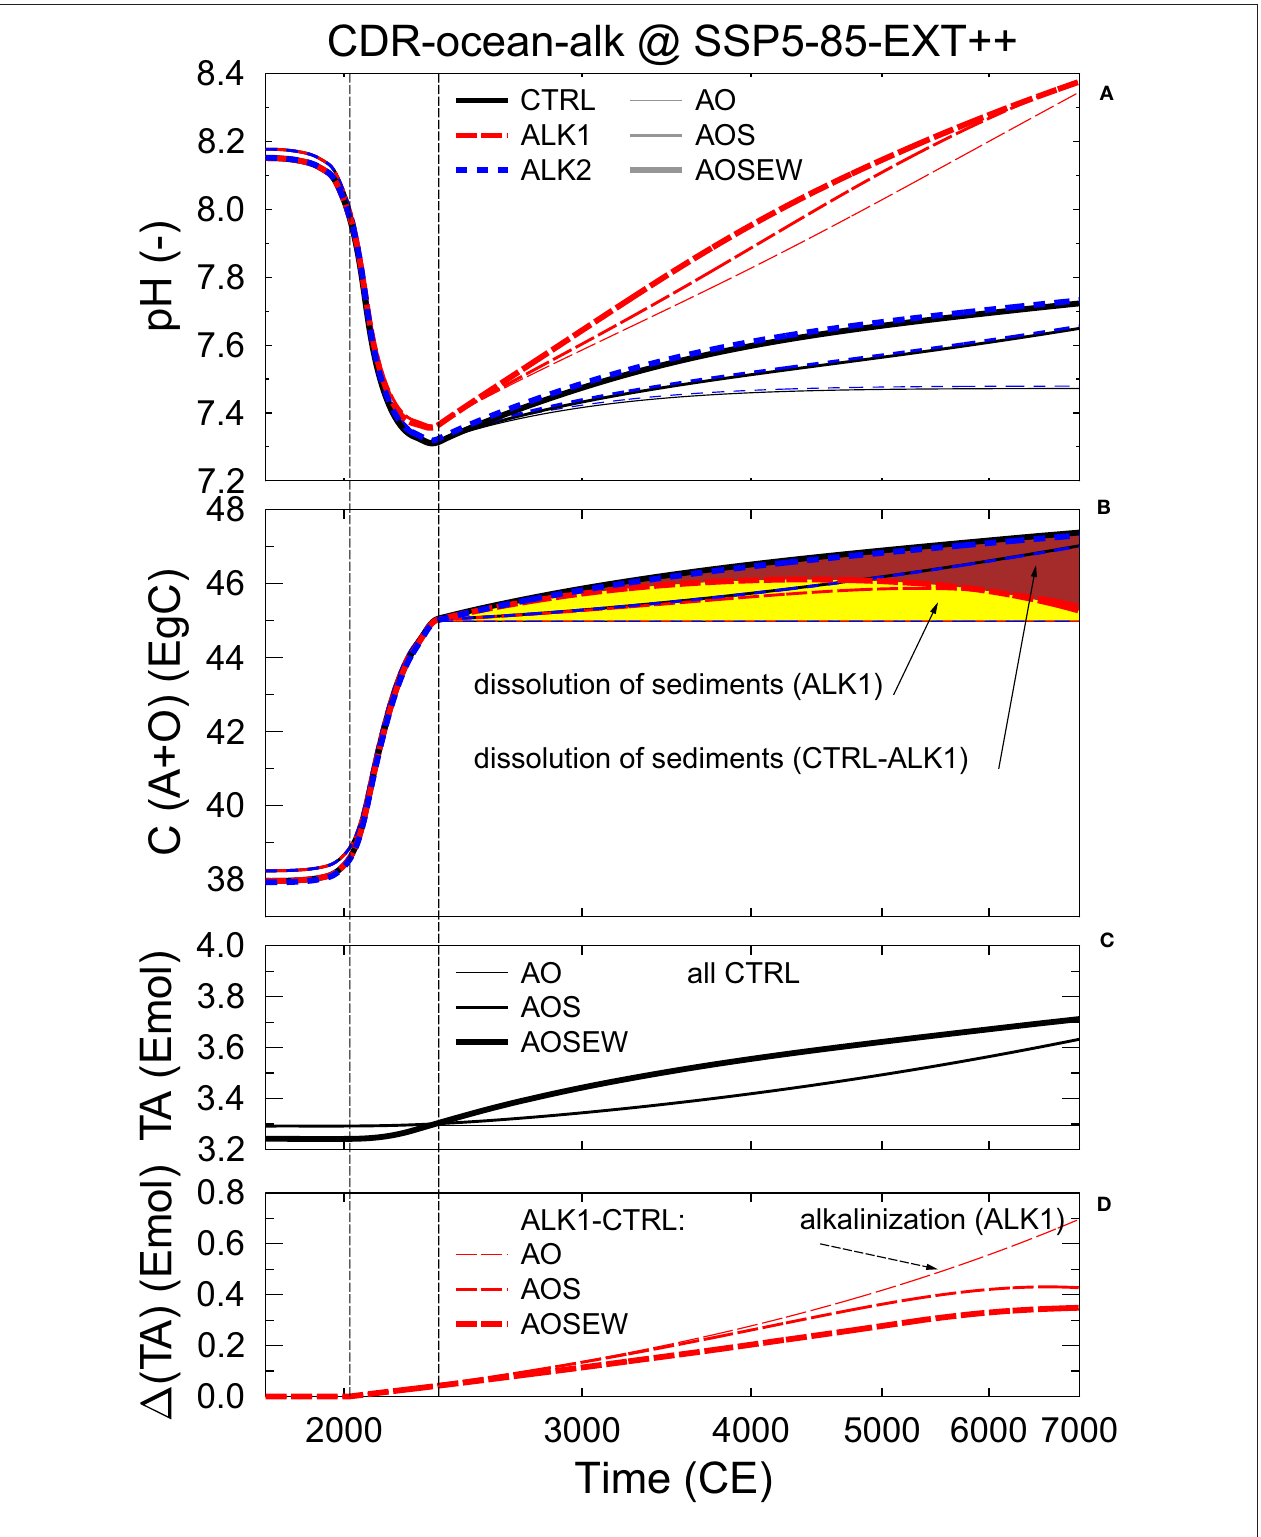
FIGURE 3 | (A) Volume-weighted mean pH of all surface ocean boxes. (B) C content of atmosphere (A) and ocean (O), marking the additional C released from the dissolution of